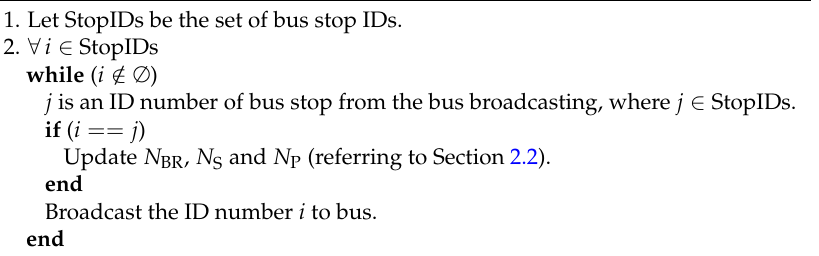
Table 2. Software design of a bus